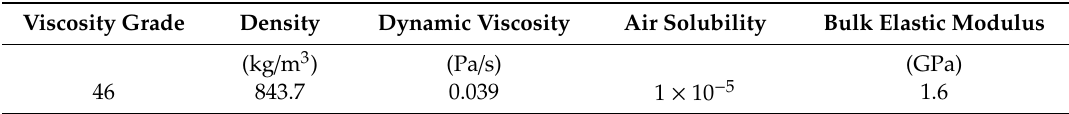
Table 3. 46# Mineral oil medium properties.